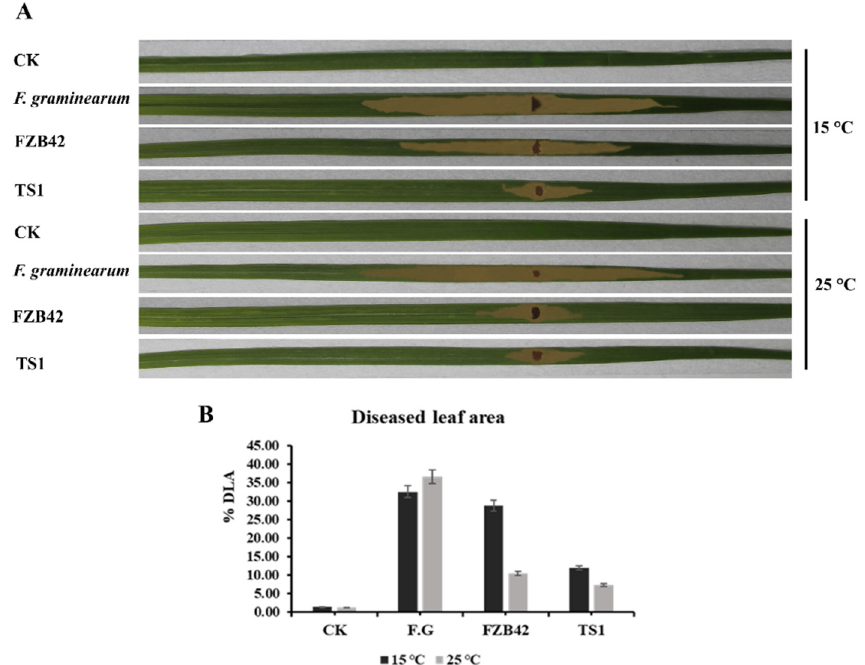
Figure 10. ( A ) The lesions on the leaves showed diseased leaf area in different wheat treatments at 15 and 25 ◦ C. ( B ) The graph shows % diseased leaf area in wheat under different treatments at 15 ◦ C and 25 ◦ C. The standard error of the means is represented by the error bars on the graphs. The statistical differences among different treatments were calculated by Tukey’s HSD test at p ≤